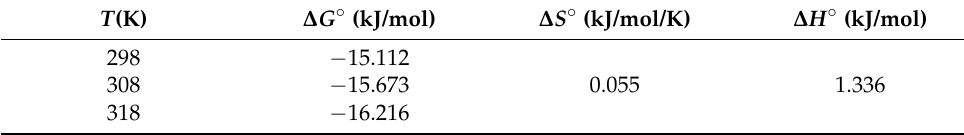
Table 5. Thermodynamic parameters of phosphate sorption on